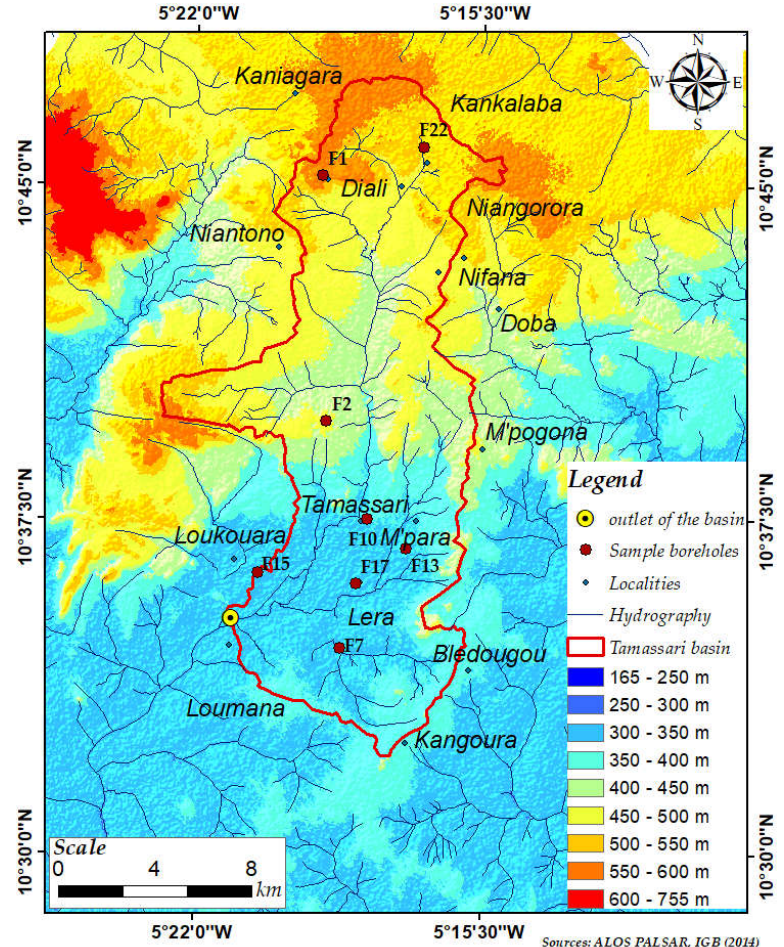
Figure 4. Relief of the study area .